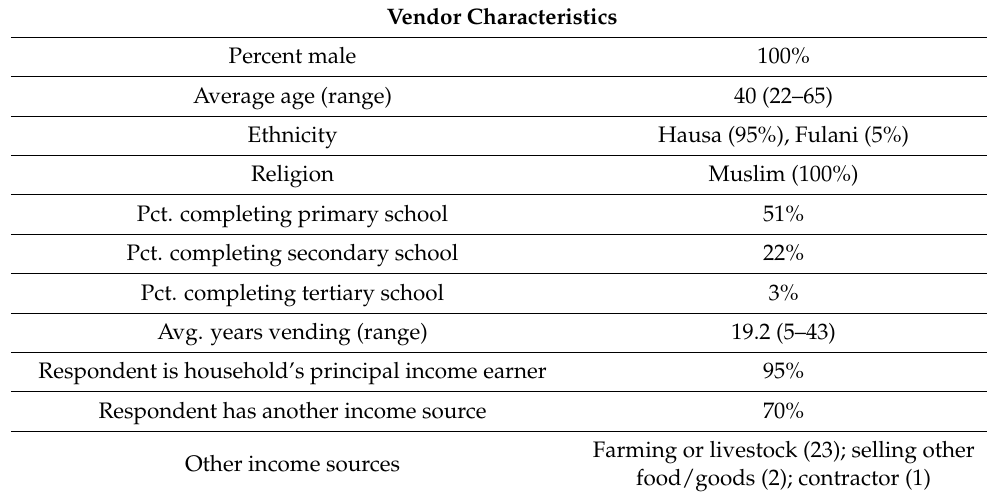
Table 2. Vendor demographic characteristics ( n =